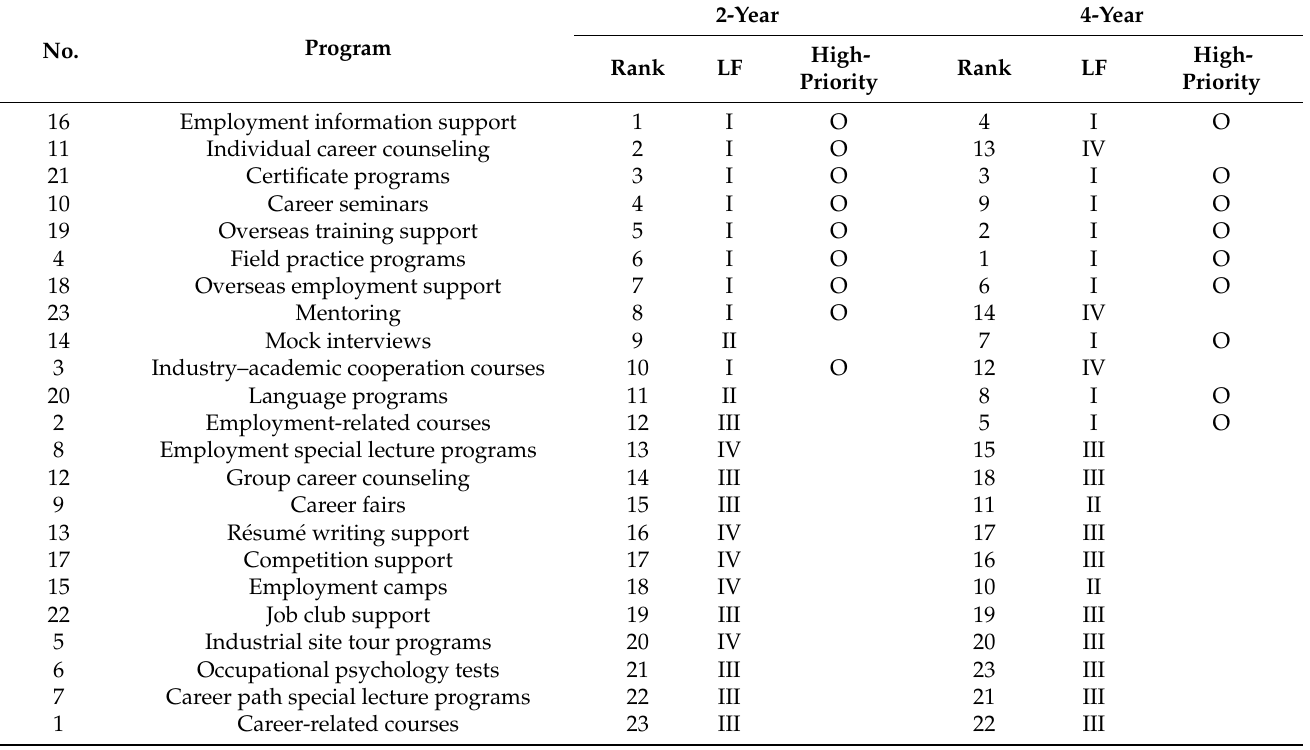
Table 4. Results of Borich needs analysis and the Locus for Focus